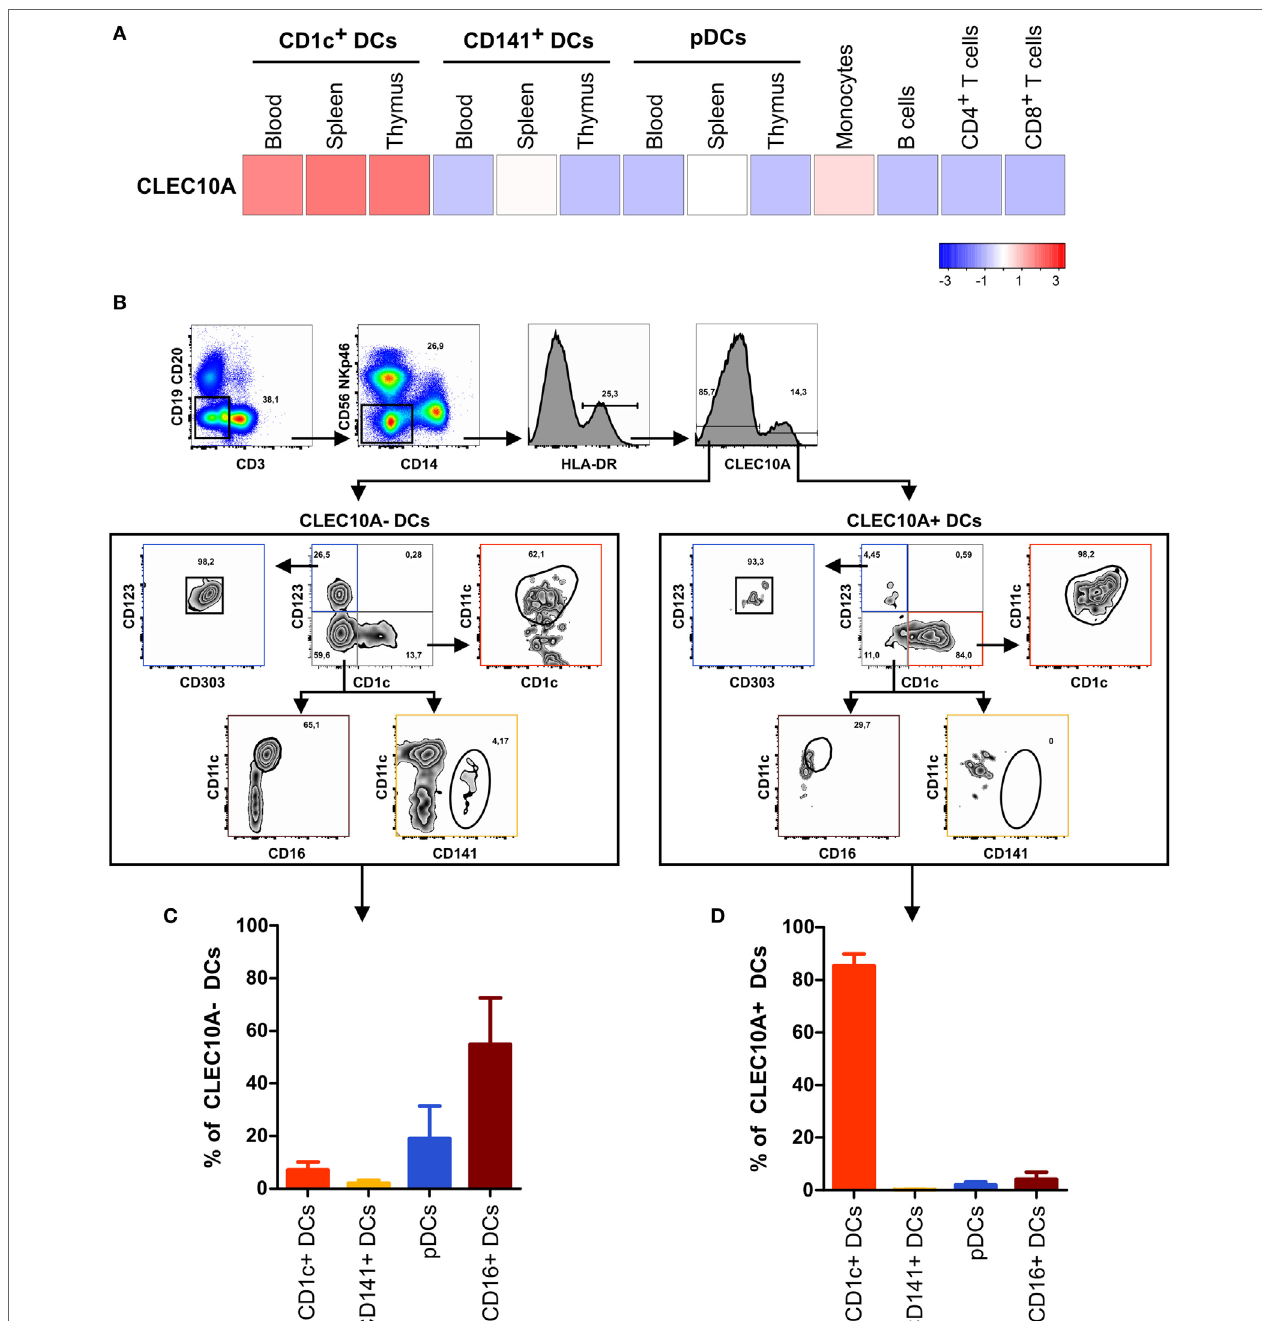
FigUre 1 | The CLEC10A + dendritic cell (DC) compartment is predominantly composed of CD1c + DCs in human blood. (a) The expression of CLEC10A was analyzed by microarray analysis. Previously published microarray data (15) were used (GEO accession number GSE77671). For these microarray data, DC subpopulations from each three blood, spleen, or thymus donors as well as blood monocytes, B cells, CD4 + and CD8 + T cells were sorted by flow cytometry, and whole human genome microarray (Agilent) analyses were performed (15). The heat map shows the relative expression of CLEC10A transcripts. (B–D) PBMCs of a healthy donor were stained with a PE-labeled anti-CLEC10A antibody as well as antibodies against different immune cell populations and analyzed by flow cytometry. (B) After exclusion of doublets and dead cells (not shown), lineage + (CD3, CD14, CD19, CD20, CD56, and NKp46) cells were excluded. In the remaining cells, HLA-DR + cells were selected and CLEC10A + and CLEC10A − cells gated. The CLEC10A + and CLEC10A − cells were then analyzed for the proportion of CD1c + DCs (CD1c + CD11c + CD123 − ), CD141 + DCs (CD141 + CD11c ± CD1c − CD123 − ), plasmacytoid DCs (pDCs) (CD123 + CD303 + CD1c − ), and CD16 + DCs (CD11c + CD16 + CD1c − CD123 − ). One representative donor is shown. (c,D) The percentages of CD1c + DCs, CD141 + DCs, pDCs, and CD16 + DCs of (c) CLEC10A − and (D) CLEC10A + cells were calculated and plotted as bar graphs (mean ± SD; n = 3).